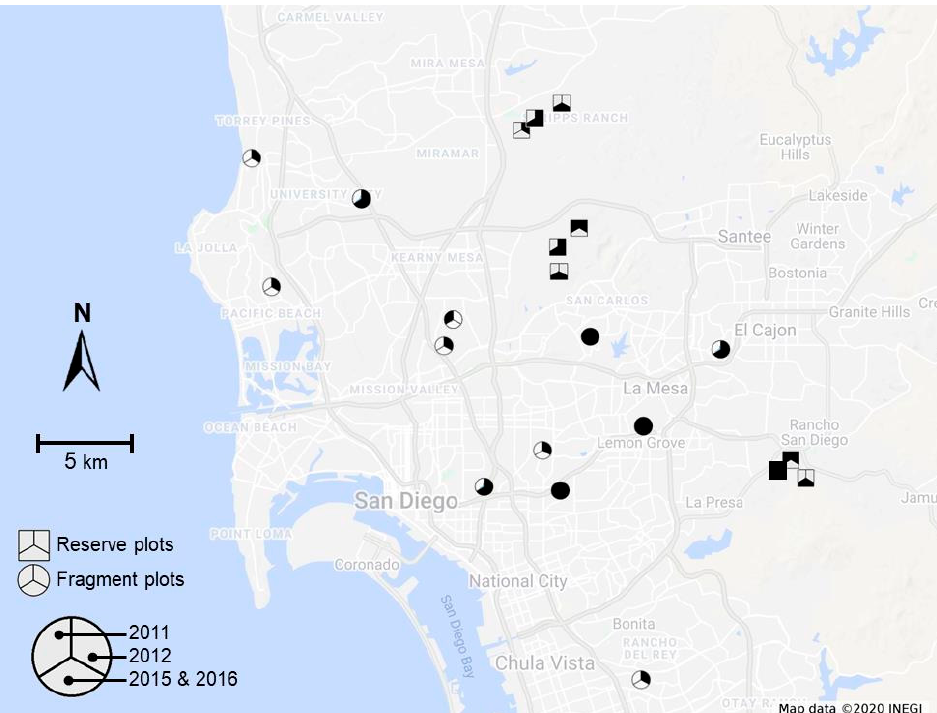
Figure 1. Map of the study region showing the location of 1-ha study plots in large scrub reserves (squares) and scrub fragments (circles). Within each symbol, filling of distinct sectors indicates the year(s) in which the plot was sampled.